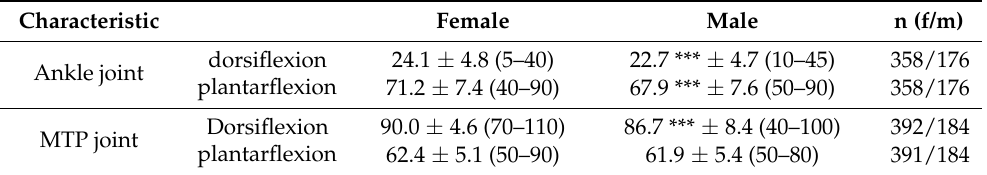
Table 6. Passive ROM of ankle and MTP joint in degrees, Mean ± SD